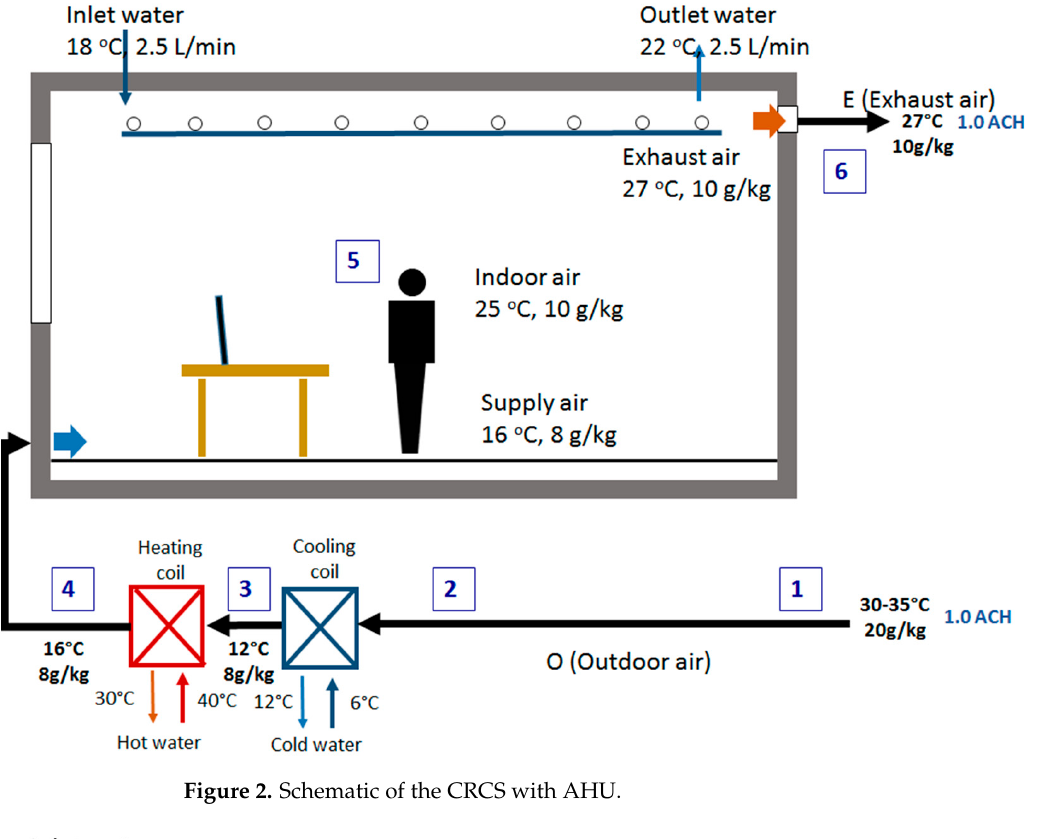
Figure 2. Schematic of the CRCS with AHU.